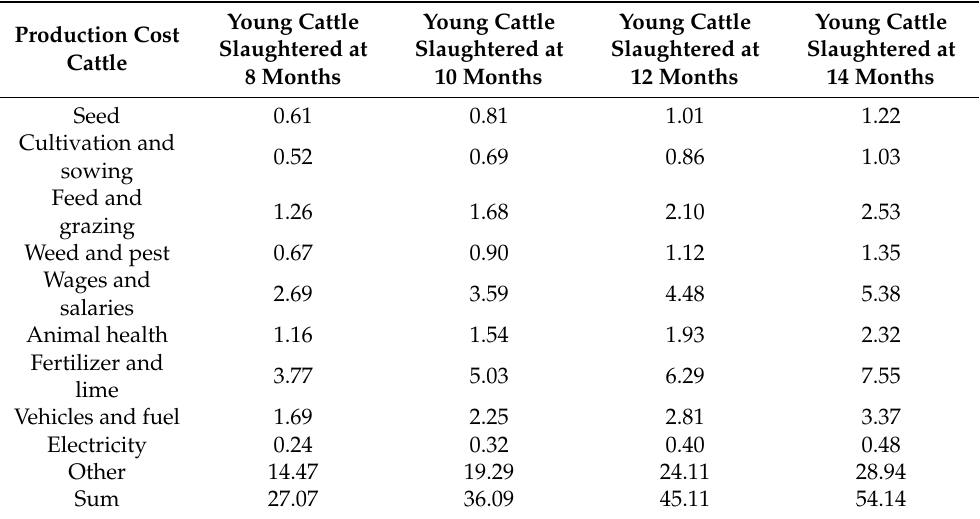
Table 2. Bimonthly per stock unit expenditure for various inputs of young beef cattle